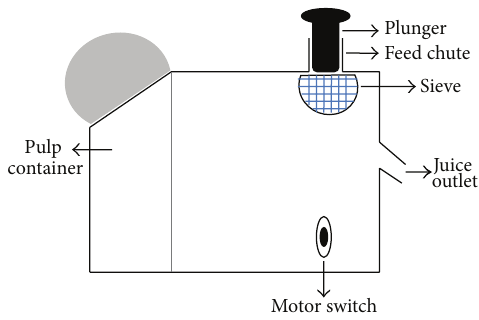
Figure 1: A schematic diagram representing the KENWOOD fruit processor used for CAJ